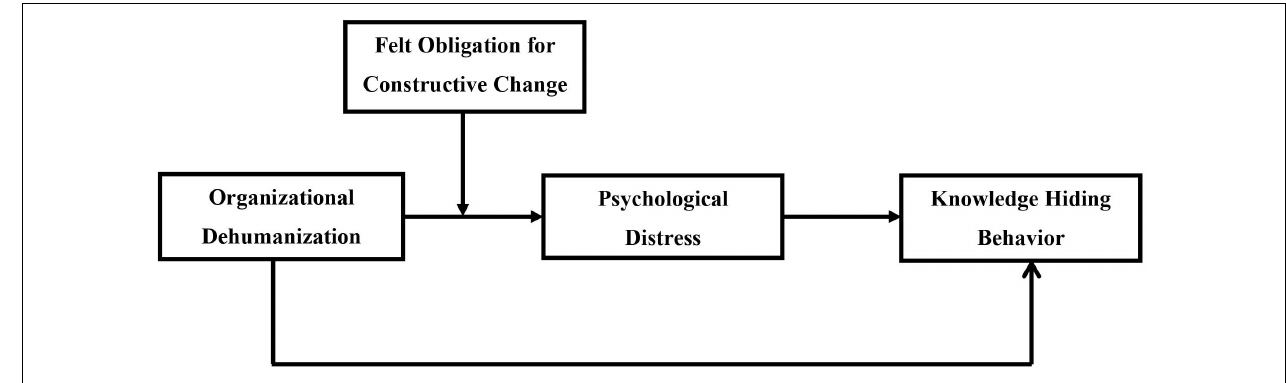
FIGURE 1 | Proposed hypothesized